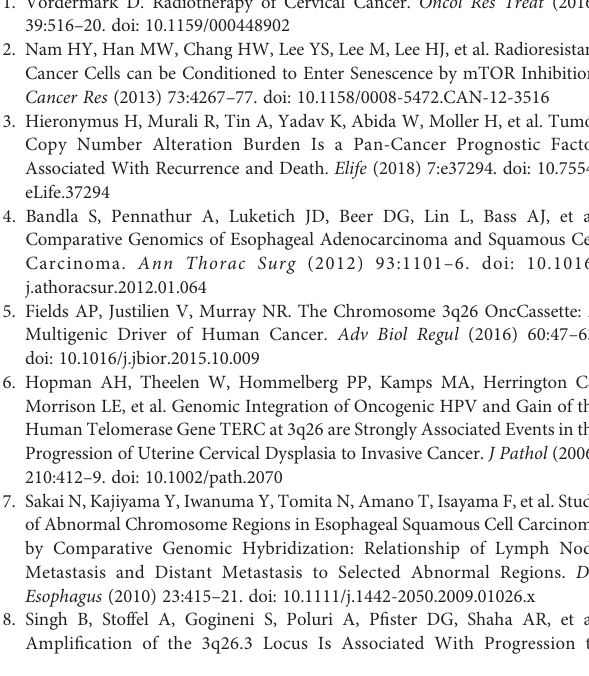
without irradiation. Data are shown as the mean ± SD. Data are shown as the mean from three independent experiments. *P < 0.05; **P < 0.01 by unpaired t tests. Supplementary Figure 7 | (A) AF increased apoptosis of HeLa and SiHa cells without radiotherapy. (B) The cell apoptosis of AF-treated HeLa and SiHa cells with and without irradiation. Data are shown as the mean ± SD. Data are shown as the mean from three inde-pendent experiments. *P < 0.05; **P < 0.01 by unpaired t tests. Supplementary Table 1 | Oligonucleotide sequences for this study. Supplementary Table 2 | SiRNAs targeting human GLI1 sequences for this study. Supplementary Table 3 | Primers used in PCR. Supplementary Table 4 | Correlation of PRKCI and SMO/GLI1 expression in